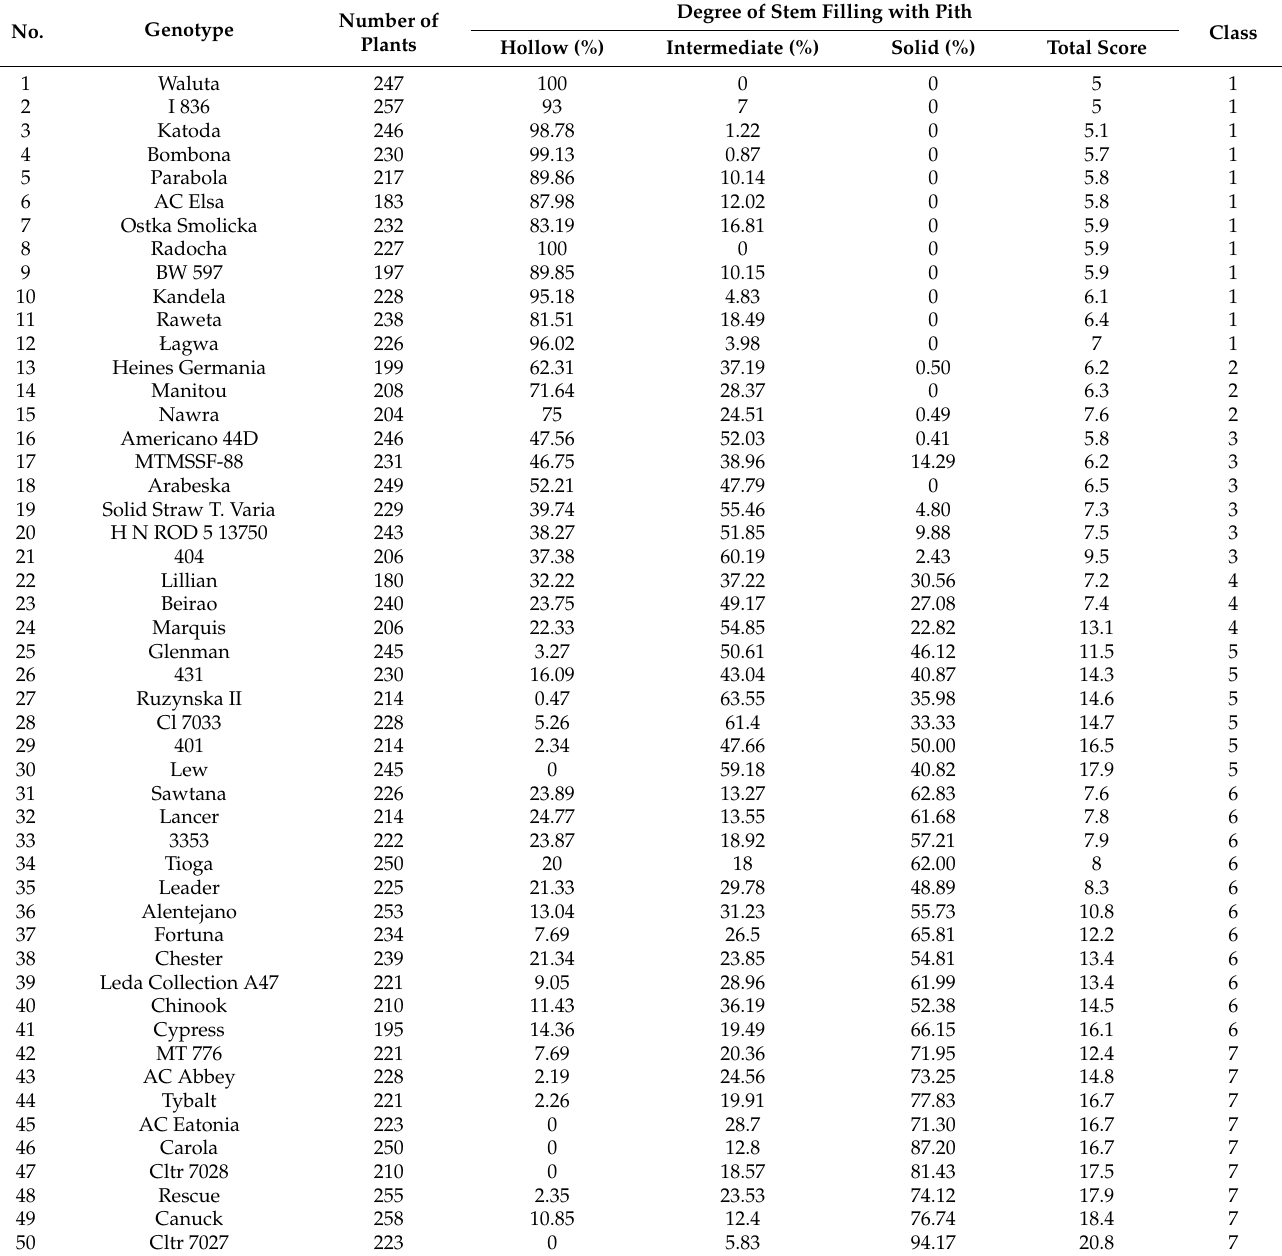
Table 2. The classification of cultivars according to the stem-solidness based on the methodology developed by DePauw and Read